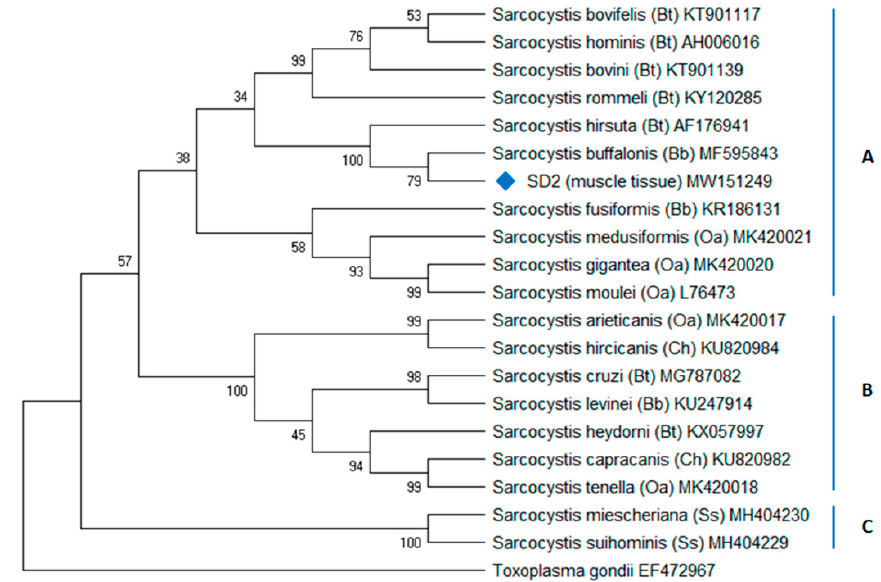
Figure 4. Phylogenetic positioning of the Sarcocystis -like organism found in muscle of striped dolphin ( Stenella coeruleoalba ) SD2 in Liguria, Italy. The evolutionary history was inferred using the maximum parsimony (MP) method. Tree n.1 out of three most parsimonious trees (length = 1532) is shown. The consistency index is (0.750000), the retention index is (0.820830), and the composite index is 0.689026 (0.615623) for all sites and parsimony-informative sites (in parentheses). The percentage of replicate trees in which the associated taxa clustered together in the bootstrap test (1000 replicates) is shown next to the branches [29].The MP tree was obtained using the subtree–pruning–regrafting (SPR) algorithm [30] with search level 1 in which the initial trees were obtained by the random addition of sequences (10 replicates). This analysis involved 21 nucleotide sequences from Sarcocystis species infecting domestic hosts that are raised in Europe (Bt, Bos taurus ; Bb, Bubalus bubalis , Ch, Capra hircus ; Oa, Ovis aries ; Ss, Sus scrofa ). In cluster B and C, a high or moderate bootstrap (BP) value at each node supported each group containing closely related Sarcocystis species with canids as the definitive host, respectively, whereas, in cluster A, some low BP values indicated that the phylogenetic position of Sarcocystis species with felids as definitive hosts is not conclusive (BP = 34–38%). These results are probably due to the fact that the 18S rRNA locus is not the most appropriate to infer phylogenetic relationships; moreover, the short length of the SD2 sequence obtained is a limitation identified here. Nonetheless, it should be noted that neighbor-joining and maximum-likelihood methods also resulted in phylogenetic trees in which S. hirsuta , S. buffalonis , and SD2 Sarcocystis sp. grouped together (data not shown). There were a total of 1974 positions in the final dataset. Evolutionary analyses were conducted in MEGA X [26].